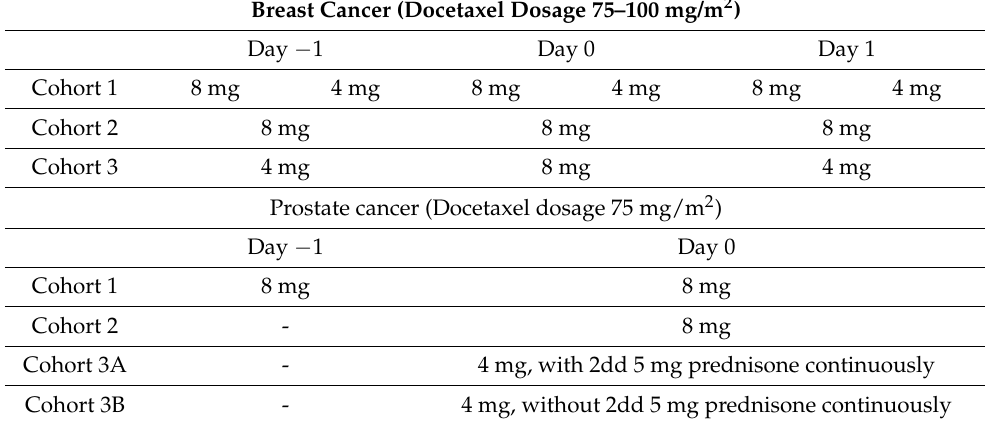
Table 1. Dose levels of dexamethasone per